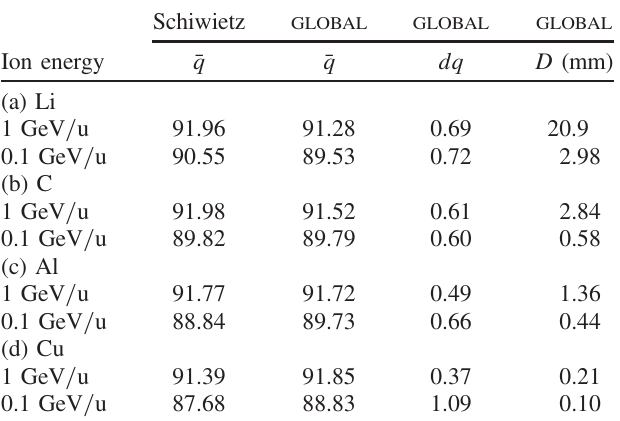
TABLE II. Average equilibrium charge ¯ q , the width of the equilibrium charge-state distribution dq , and the equilibrium thickness D for 0.1 and 1 GeV = u 238 U ions in Li, C, Al, and Cu targets, calculated by using the formula by Schiwietz and the code GLOBAL .